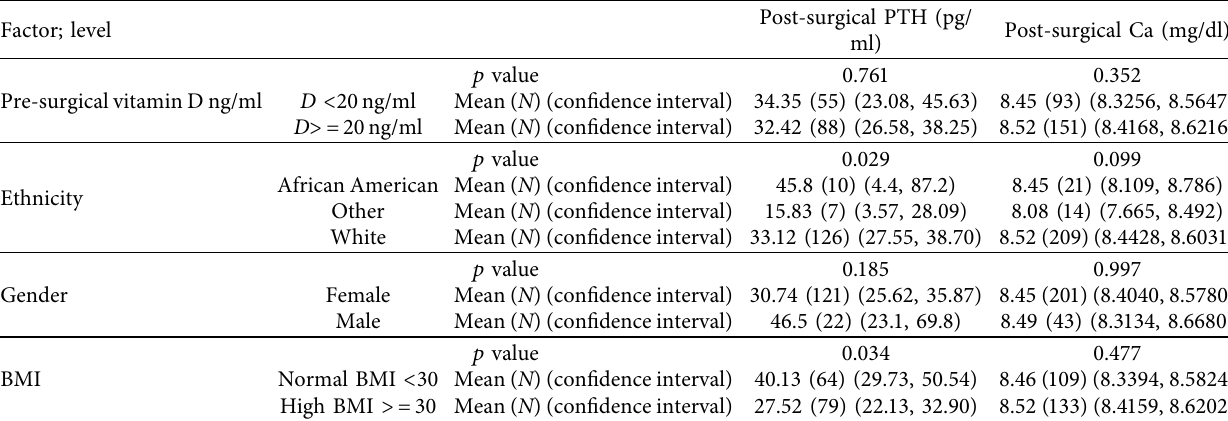
Table 2: Relationship of post-surgical PTH and Ca levels with potential risk factors for post-operative hypocalcemia. Factor; level